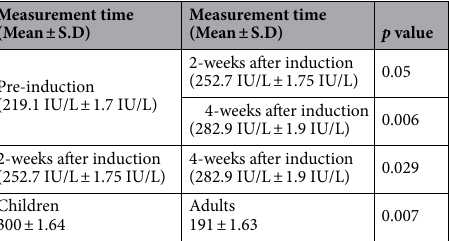
Table 7. Compares the mean of alkaline phosphate before and after induction.